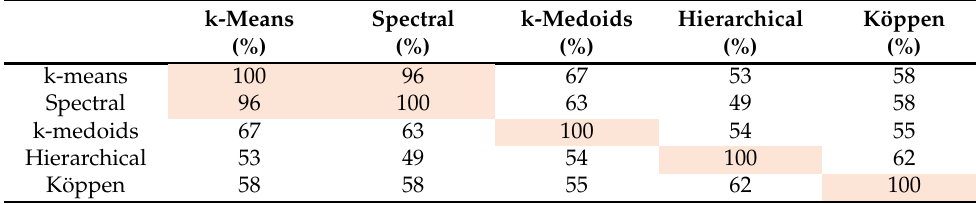
Table 6. Jaccard Index (JI) for 3